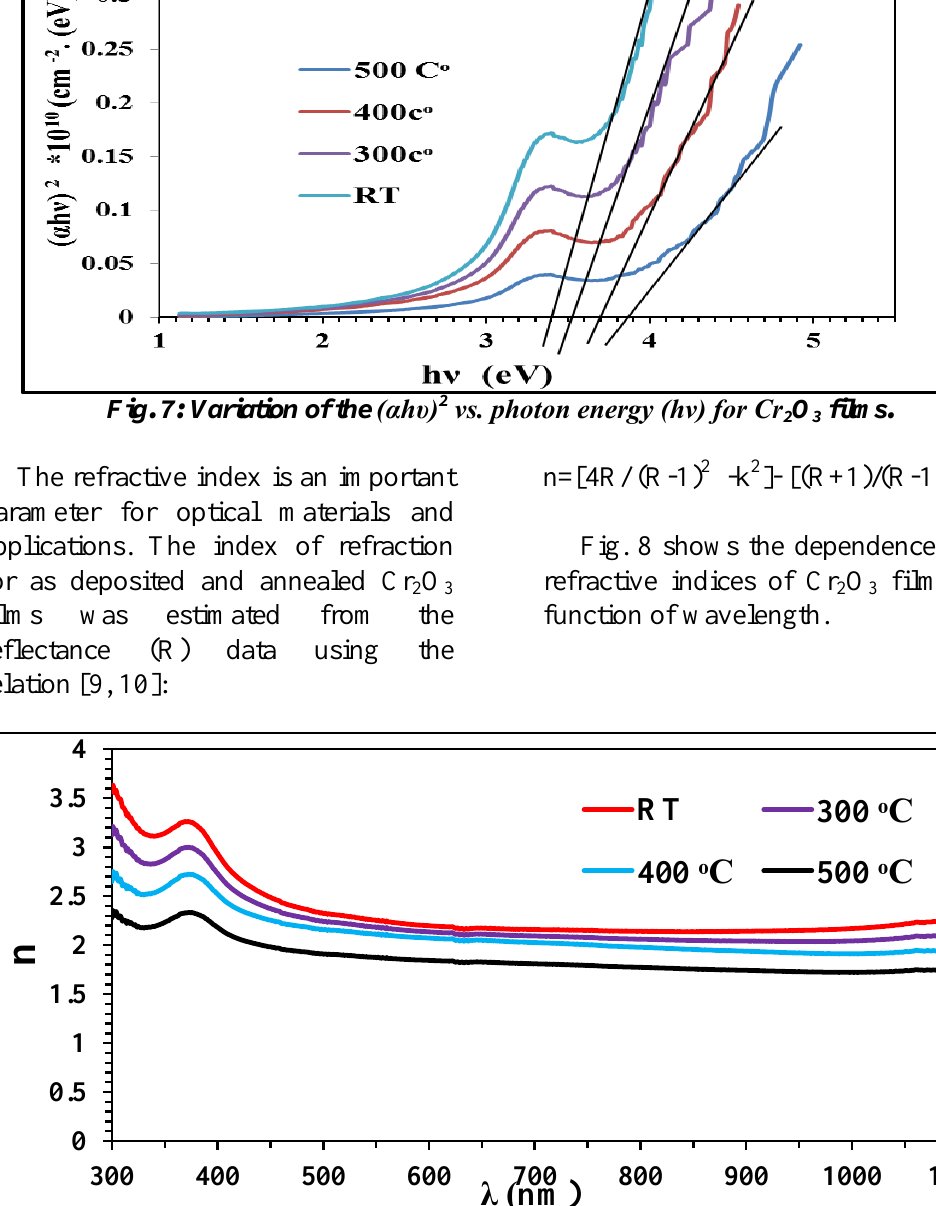
O films at different annealing temperature as a 2 3